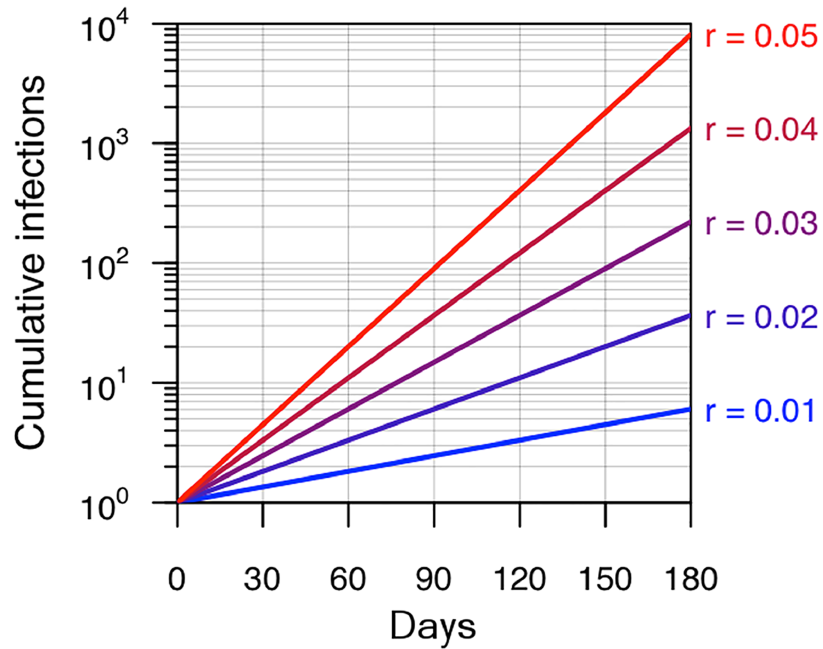
Fig 6. Epidemic growth under an exponential model with values of the epidemic growth rate r ranging from 0.01 to 0.05 for a duration of 180